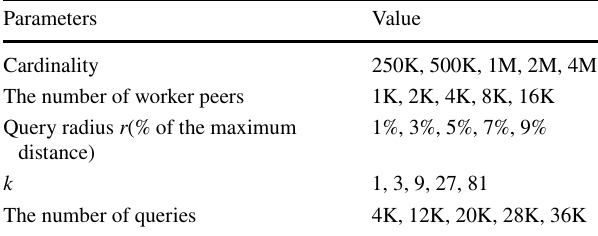
Table 3 Parameter